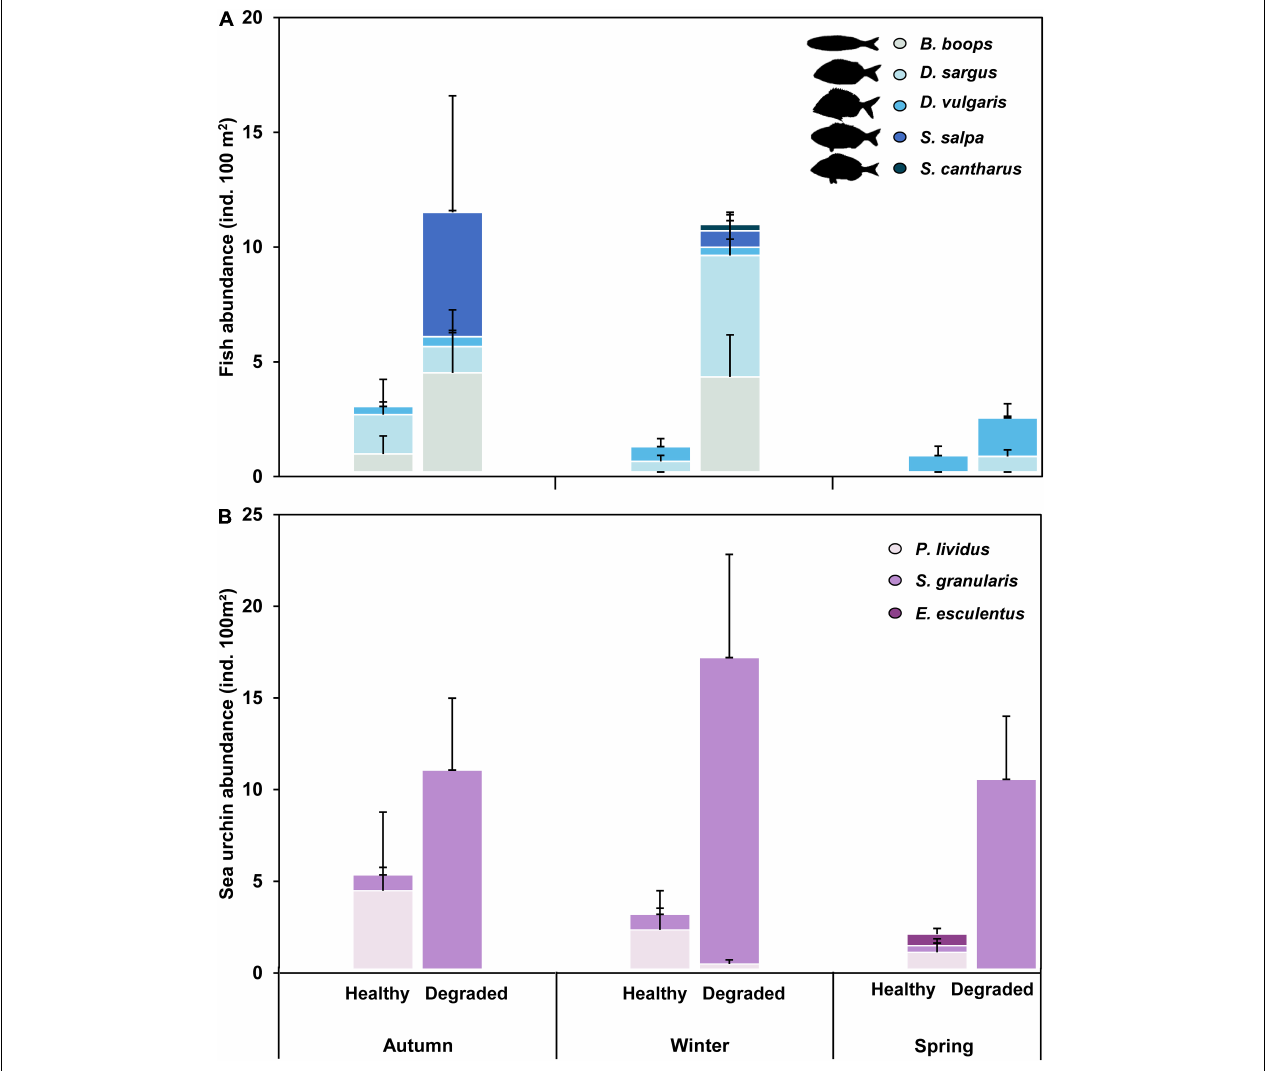
FIGURE 7 | Abundance (mean + SE) of (A) fish and (B) sea urchins on healthy and degraded golden kelp reefs in autumn, winter and spring. Only fish that included seaweeds in their diet